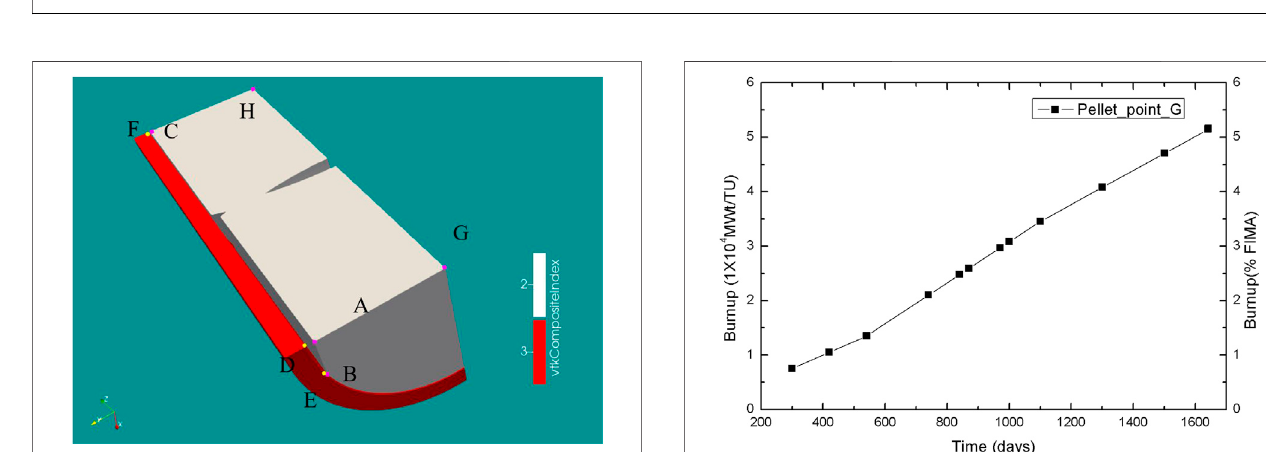
FIGURE 7 | Experimental measured and predicted temperature at the upper end of the centerline (left) , and temperature at the lower end of the centerline (right) for 513r6.